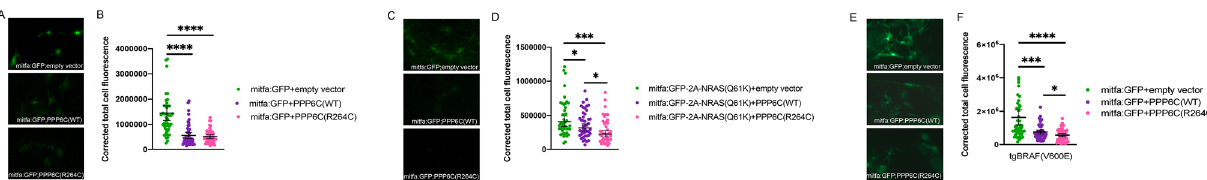
Figure 4. MITF promoter activity is reduced under expression of PPP6C(WT) and PPP6C(R264C) on multiple oncogenic backgrounds. ( A , C , E ) Representative confocal imaging of fluorescent pigment less melanocytes of tg BRAF(V600E); nacre;p53(M214K);albino, roy;nacre, or roy;nacre;p53(M214K) fish injected with a GFP reporter under control of the mitfa promoter. ( B , D , F ) Representative quantification of fluorescence for each genotype. Fish were imaged under a confocal microscope and total fluorescence was quantified for 10 melanocytes on N = 5 fish of each genotype. All data panels in the figure are representative of at least three experiments (Student’s two-tailed t-test). p -values are indicated as following: * p < 0.05, *** p ≤ 0.001, **** p ≤ Phosphatases continue to emerge as important and druggable targets across multiple human cancers. SHP2, a tyrosine phosphatase involved in MAP kinase signaling acquires gain of function mutations such as D61Y that enhance its activity. These gain of function mutations are found in a variety of cancer types such as lung cancer, acute myeloid leukemia, and colon cancer 33 . Recently, SHP2 inhibitors such as SHP099 have shown promising efficacy in preclinical experiments and have entered clinical trials 34 . The recurrent R264C mutation in PPP6C may be another critical drug target as it is uniquely found in human melanoma. Treatment of patients with BRAF(V600E) melanoma with BRAF and MEK inhibitors such as dabrafenib and trametinib have proven to prolong patient survival 2 . However, about half of patients do not respond to inhibition and show progression of disease. It has been shown that in some melanomas, reducing MITF expression can sensitize cells to chemotherapeutics 15 , consistent with the rheostat model of modulating MITF expression in